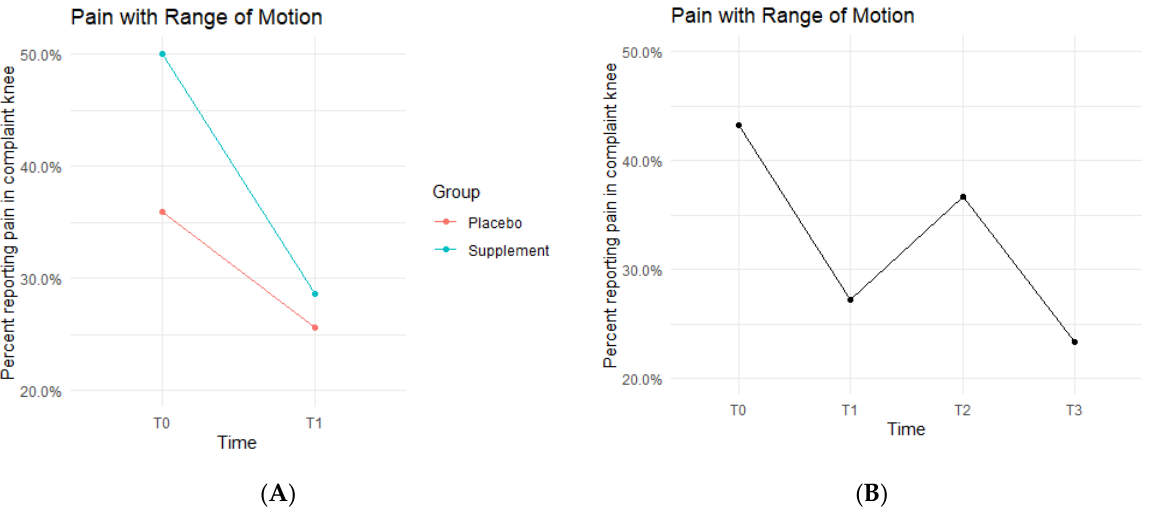
Figure 4. Pain with ROM Changes Over Time. Average percentages of participants experiencing pain with ROM were graphed on a plot. ( A ) compares pain with ROM changes in the Supplement vs. Placebo group from T0 to T1. ( B ) shows averages in pain with ROM for the entire cohort as a whole at times T0, T1, T2, and T3. Overall, the cohort started with 43.2% experiencing pain with ROM, and dropped to 23.4% by the end of the study. Only affected knees were included.